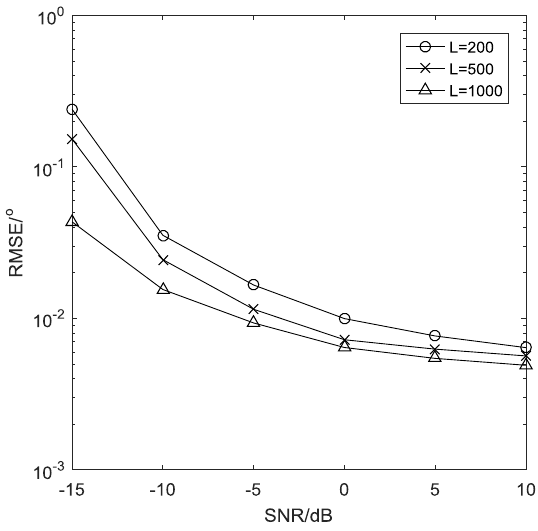
Figure 9. Estimation performance with different L .